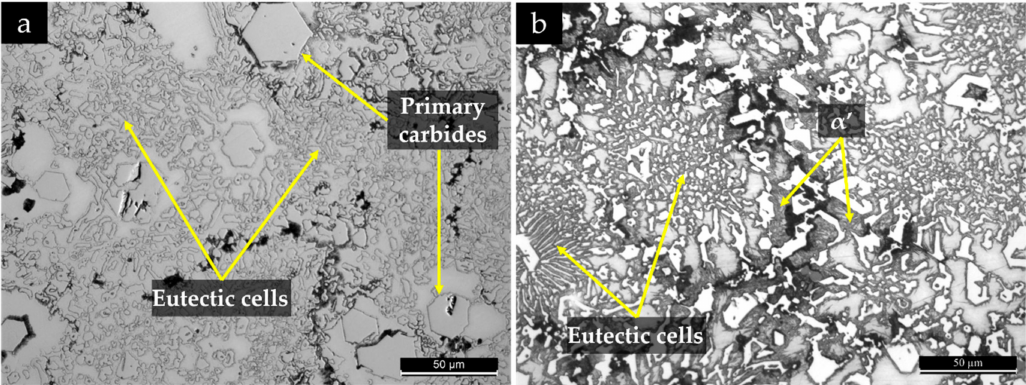
Figure 8. Optical image of the high-chromium white cast iron in the as-cast condition, after chemical etching with 2% Nital ( a ) and Beraha-Martensite ( b